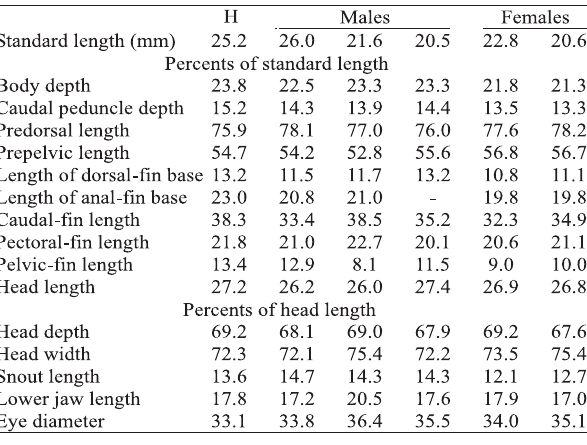
Table 7. Morphometric data of the holotype (H, UFRJ 5973, male) and paratypes (UFRJ 5974) of Rivulus egens